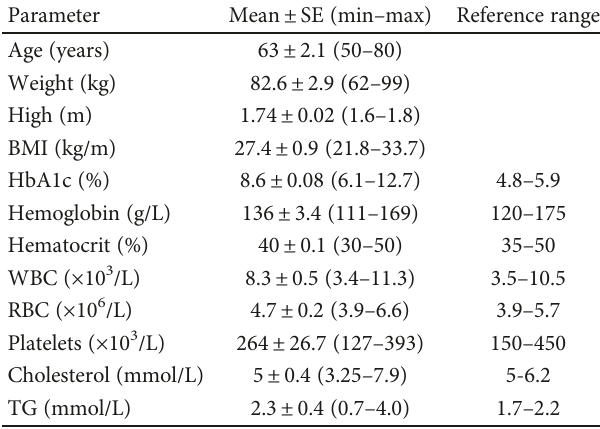
Table 1: Anthropometric and metabolic parameters of T1DM patients. Results are presented as mean ± SEM : HBOT: hyperbaric oxygen therapy; T1DM: type 1 diabetes mellitus; BMI: body mass index; HbA1c: glycosylated hemoglobin; WBC: white blood cells; RBC: red blood cells; TG: